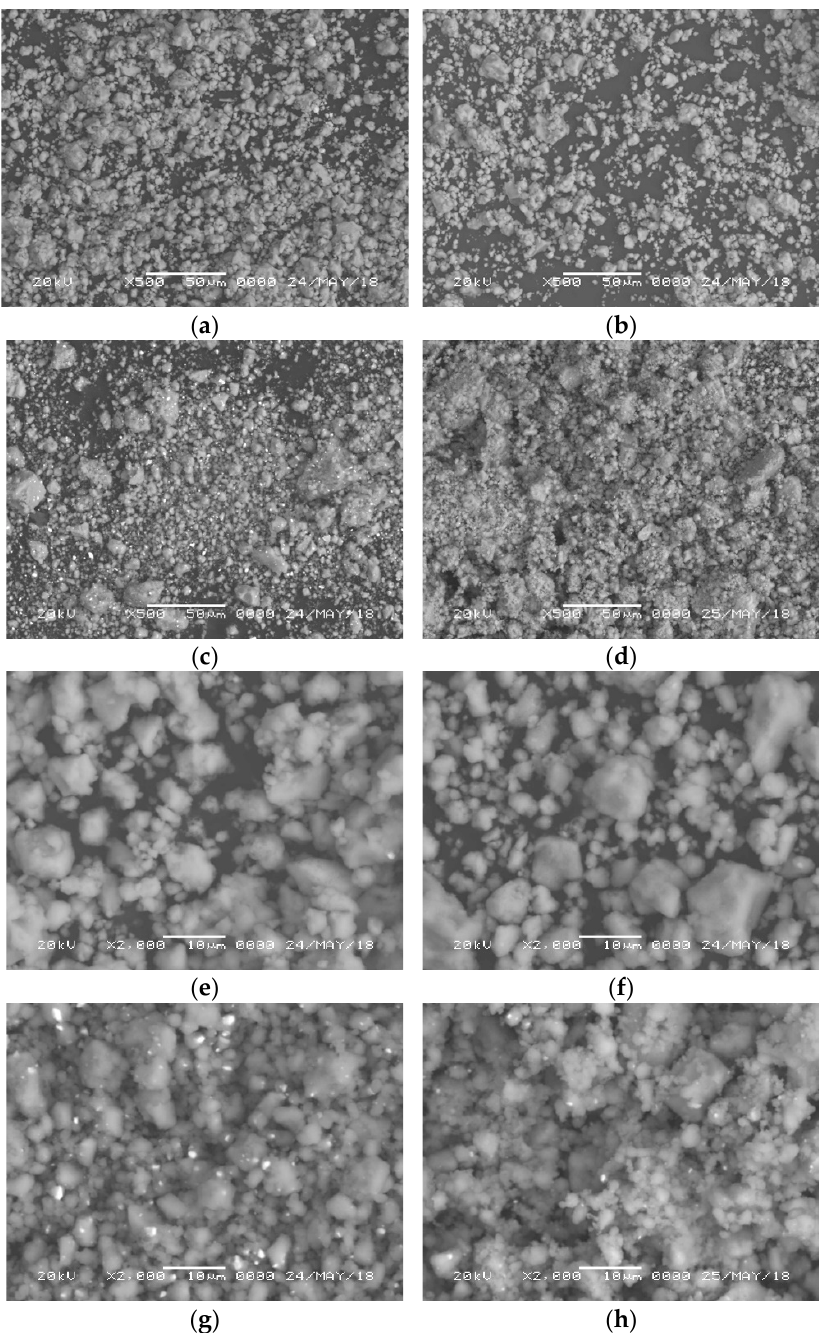
Figure 2. SEM images of ( a ) KSi–10%ZrCl 4 ; ( b ) KSi–10%ZrF 4 ; ( c ) KSi–10%ZrH 2 ; ( d ) KSi–10%ZrO 2 (secondary electron mode); ( e ) KSi–10%ZrCl 4 ; ( f ) KSi–10%ZrF 4 ; ( g ) KSi–10%ZrH 2 ; and ( h ) KSi– 10%ZrO 2 (back ‐ scattered electron mode).